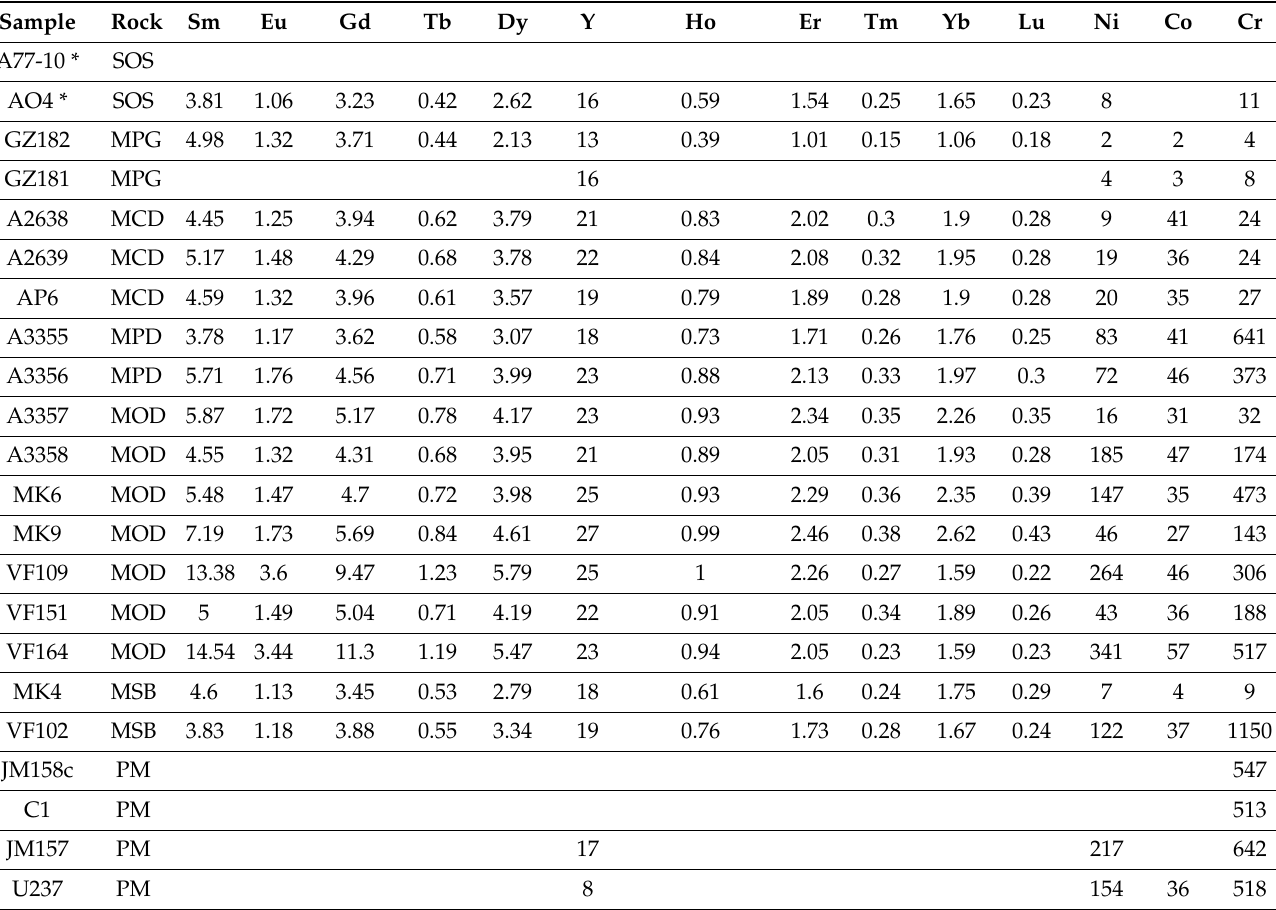
Table 4. Sr–Nd data for Corno Alto-M. Ospedale samples. Sr initial ratios and ε Nd have